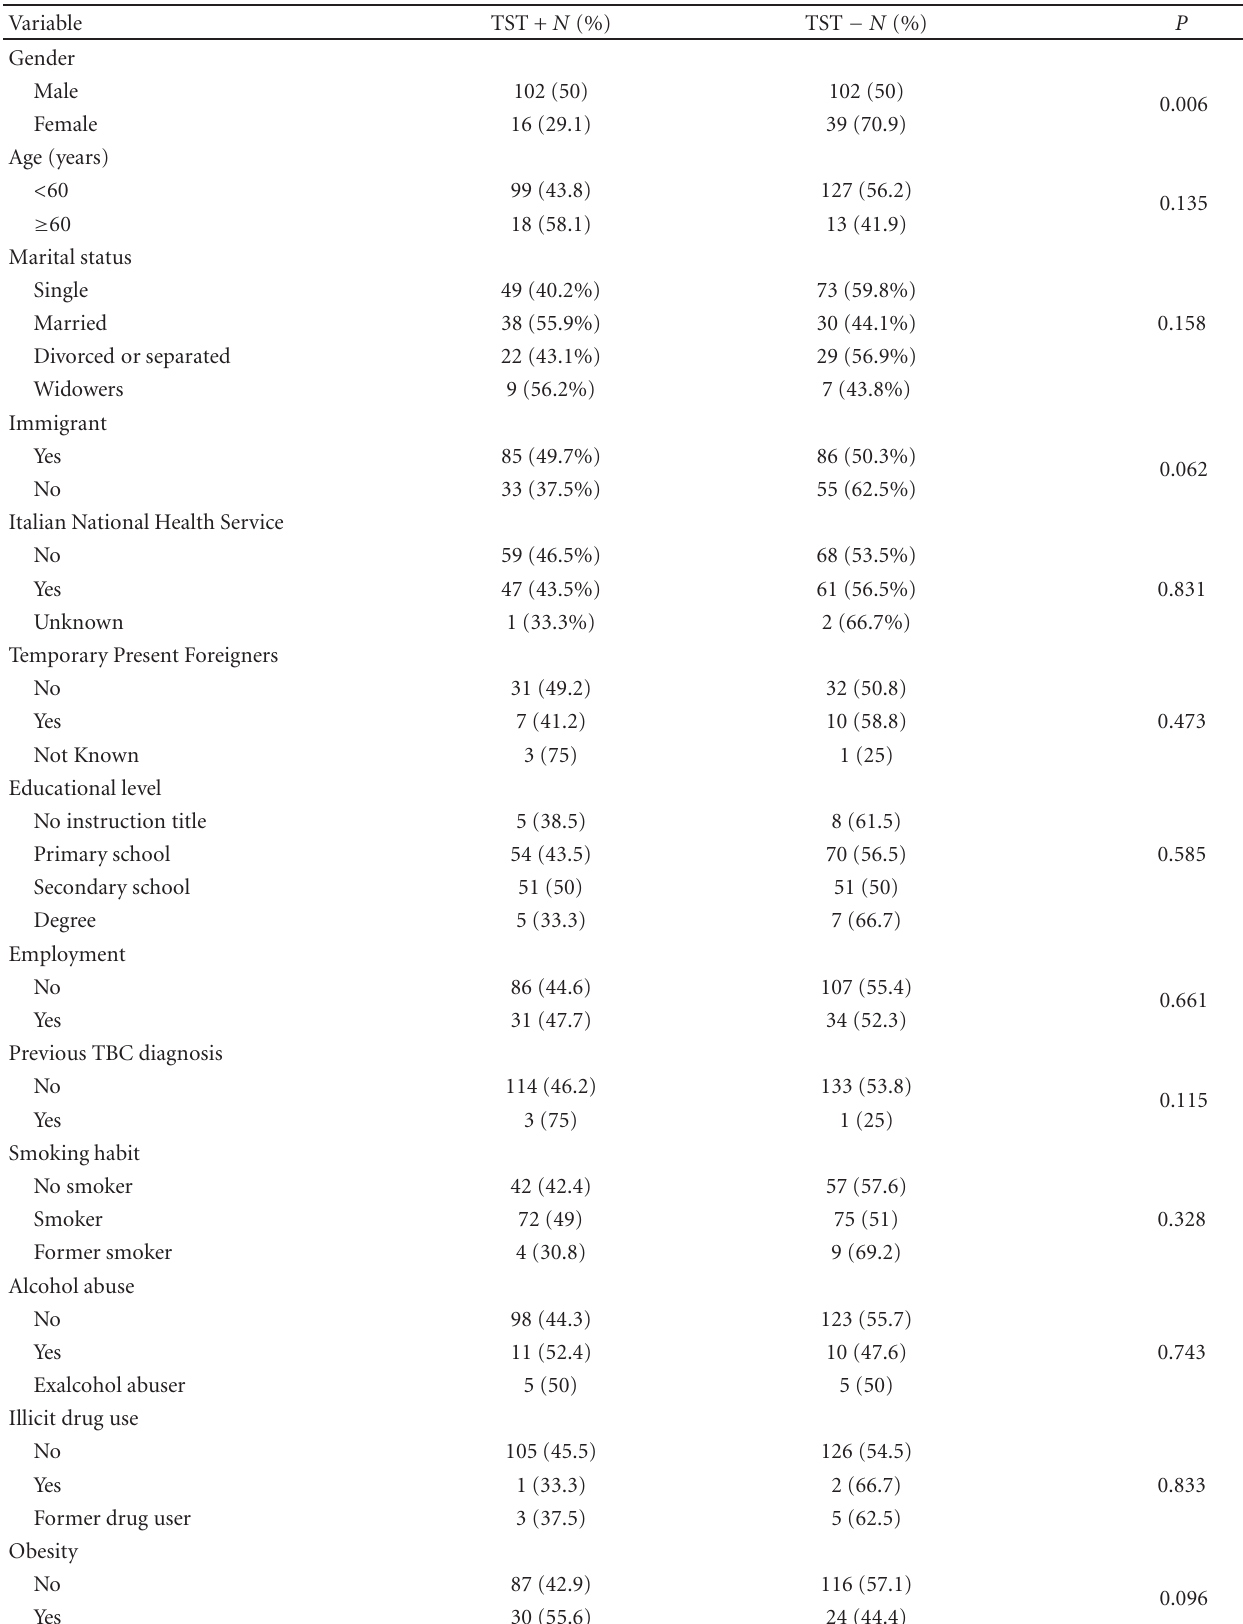
Table 1: Characteristics of participants according to the TST